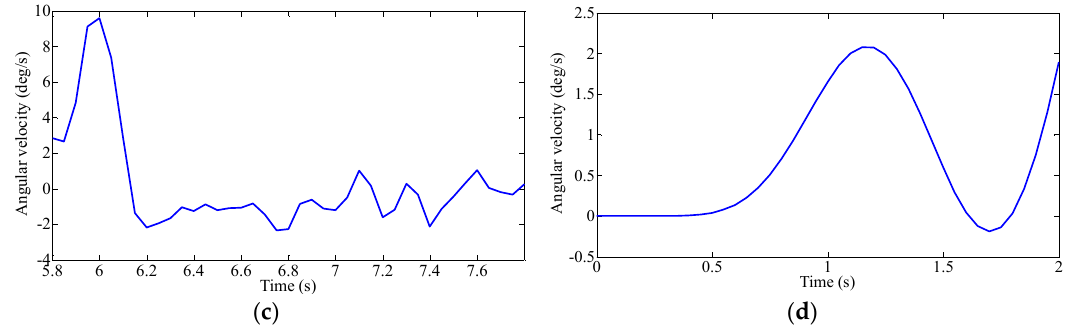
Figure 5. Angular velocity under different steering conditions: ( a ) turning right; ( b ) U-turn; ( c ) lane keeping; ( d ) lane changing.